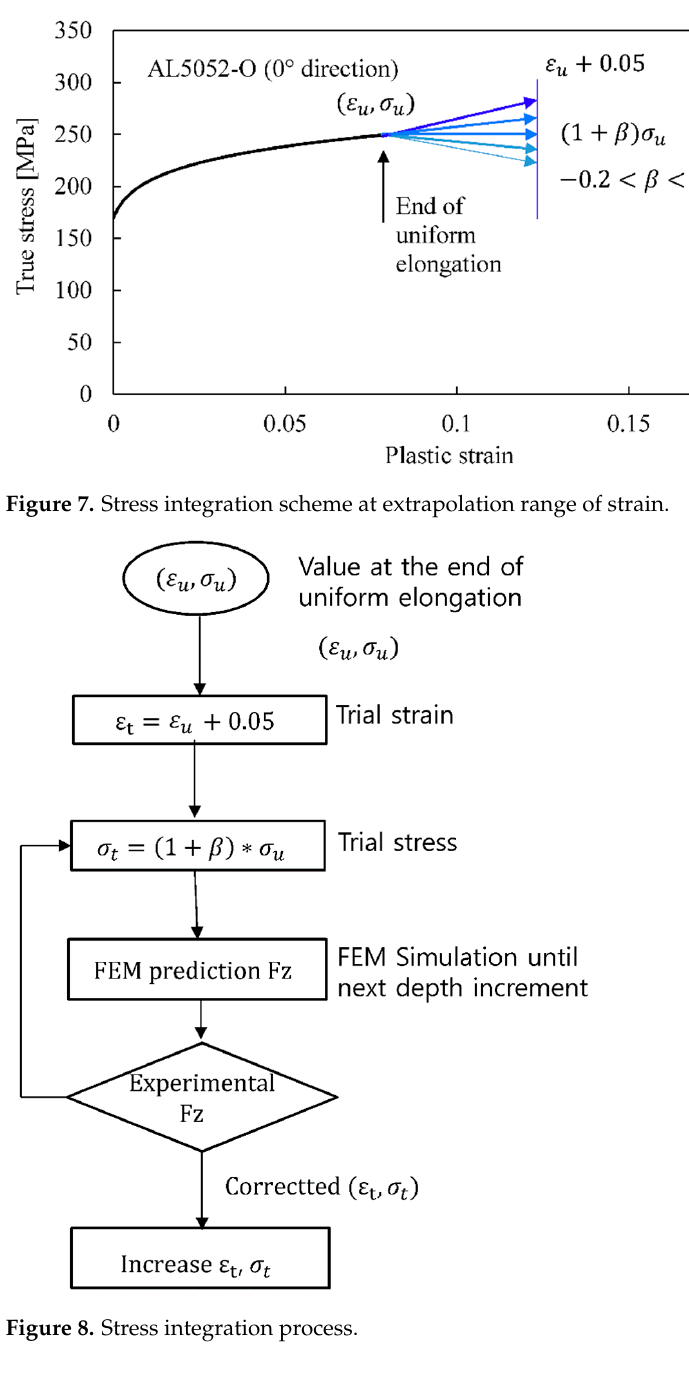
( b ) Figure 9. ( a ) Force prediction for the first three forming steps with the increment strain of (𝜀 (cid:3048) + 0.05) . ( b ) Best-fitted trial stress–trial strain in large strain range. The force prediction by the FEM model with the best-fitted trial stress–trial strain curve and FEM model with the Voce hardening equation was performed. In these simulations, the previously defined forming limit curve at fracture (FLCF) [12] was applied to predict the fracture occurrence. The forming limit curve at fracture for AA5052- O was illustrated as the following equation, where 𝜀 (cid:2869) and 𝜀 (cid:2870) are the major and minor strains, respectively. 𝜀 (cid:2869) = −1.04𝜀 (cid:2870) + 1.24 (7) During the simulation process, the fracture occurred in an element when its FLDCRT value, which is defined by the ratio of the major calculated strains ( 𝜀 (cid:2869)(cid:3030)(cid:3028)(cid:3039) ) and the FLCF values ( 𝜀 (cid:2869)(cid:3007)(cid:3013)(cid:3004)(cid:3007) ) at the same point for the minor strains ( 𝜀 (cid:2870) ), reached the unit value. In both simulations, if the FLDCRT value for elements in the center area was over the unit first, the elements were deleted (Figure 10a). However, the FEM model with the best- fitted trial stress–trial strain curve predicted the fracture at the 21st depth increment (forming depth is 5.25 mm), while the FEM model with the Voce hardening equation